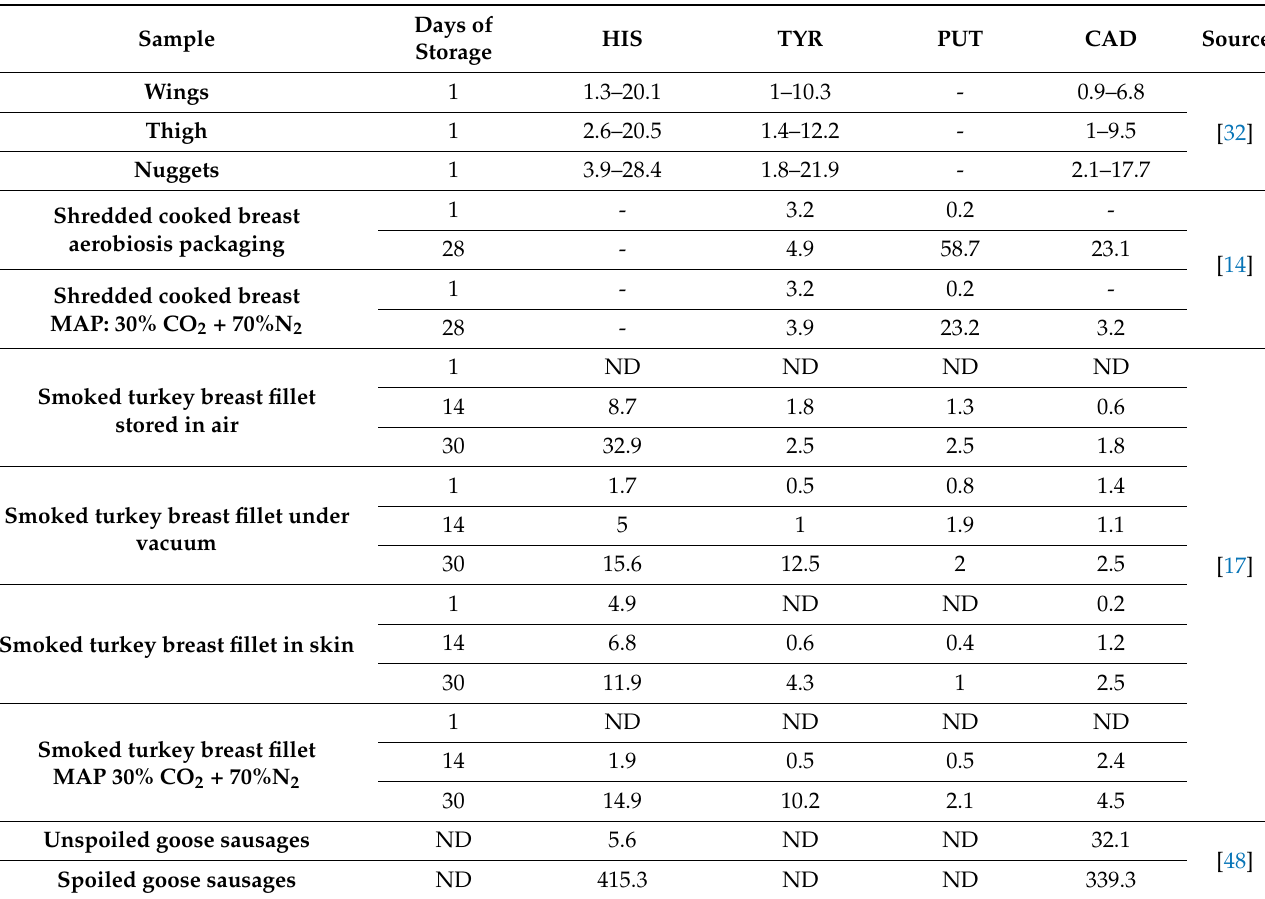
Table 3. Content of biogenic amines (HIS: histamine, TYR: tyramine, PUT: putrescine, CAD: cadaver- ine) in different poultry